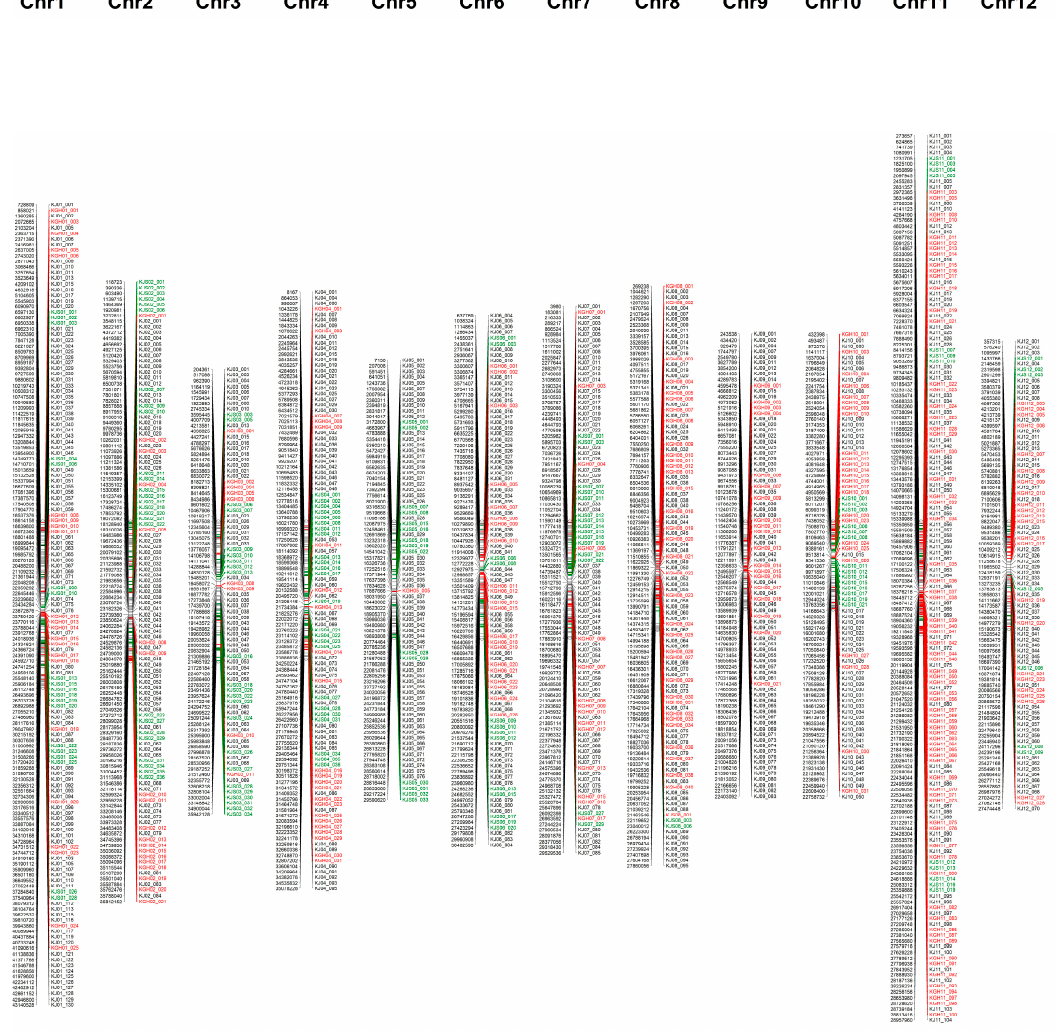
Figure 1. Physical map of 1225 KASP markers. Left and right sides of each chromosome indicate positions (bp) and names of markers, respectively. Black, red, and green text indicate KJ, KGH, and KJS KASP markers,